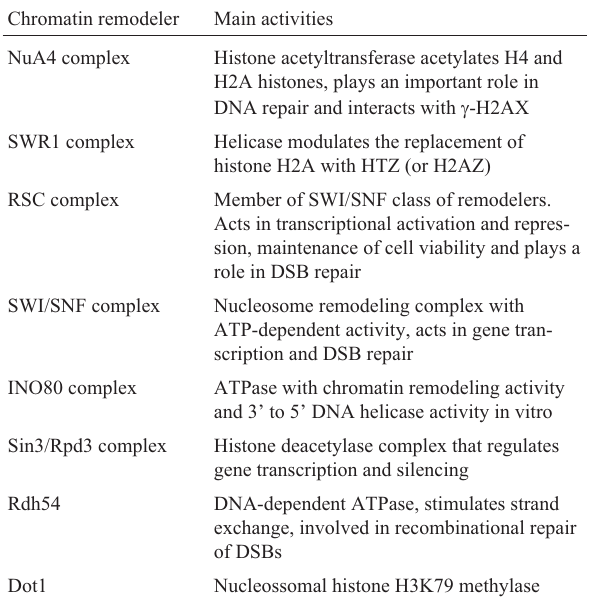
Table 1 - Summary of the main activities of chromatin remodeling in